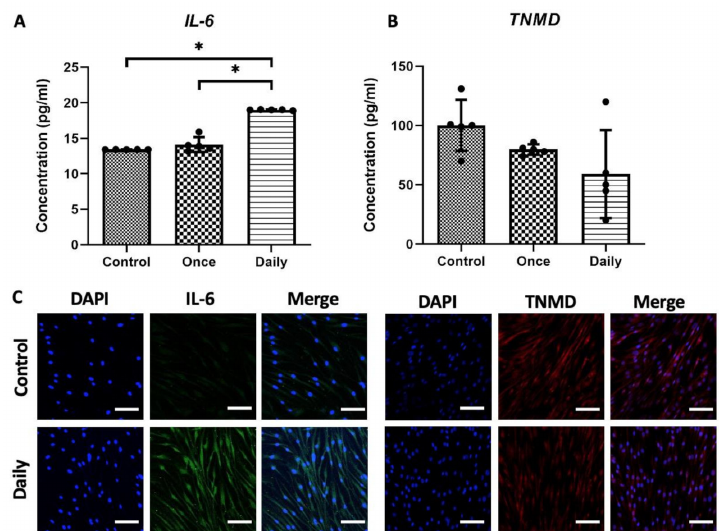
Figure 3. Enzyme-linked immunosorbent assay (ELISA) results of proinflammatory marker and tendon-specific marker in tenocytes treated with phosphate-bu ff ered saline or substance P (SP). Interleukin-6 (IL-6) concentration in growth media on day 10, measured using ELISA. Data are represented as mean ± standard deviation. Kruskal-Wallis test with Tukey’s post-hoc test was used for statistical evaluation. n = 5. * p < 0.05. ( A ). Tenomodulin (TNMD) protein concentration in growth media on day 10, measured using ELISA. Scattered dots are used to show variables. ( B ). Cells were counterstained with DAPI (4 (cid:48) ,6-diamidino-2-phenylindole, dihydrochloride) to show nuclei (blue), IL-6 (green), and expression of TNMD (red) ( C ). Original magnification: 200 × . Experiments were performed in triplicates. Scale bar = 50 µ m.